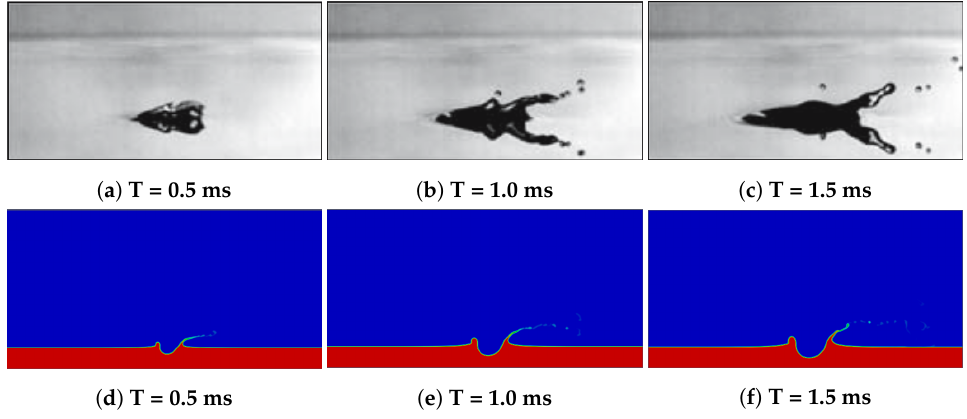
Figure 2. A comparison between experiment [12] and the simulation outcome (lower).